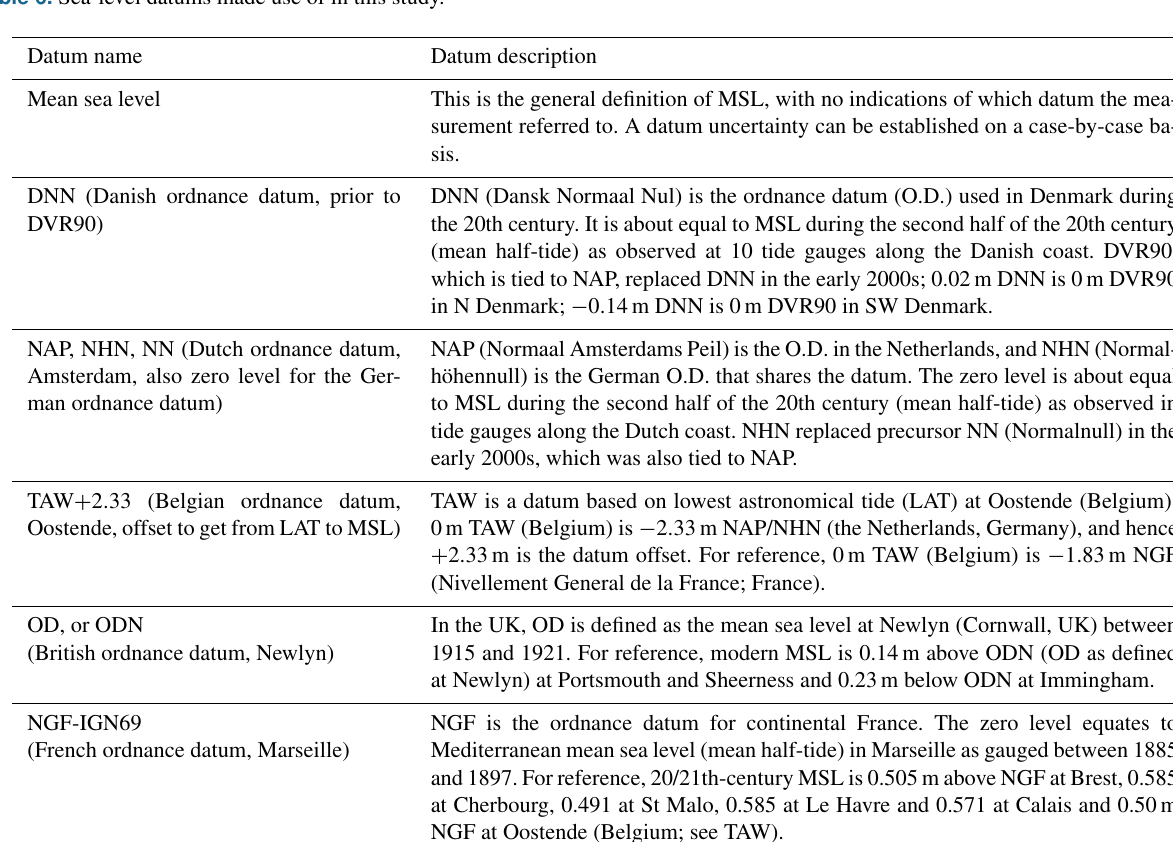
Table 6. Sea-level datums made use of in this